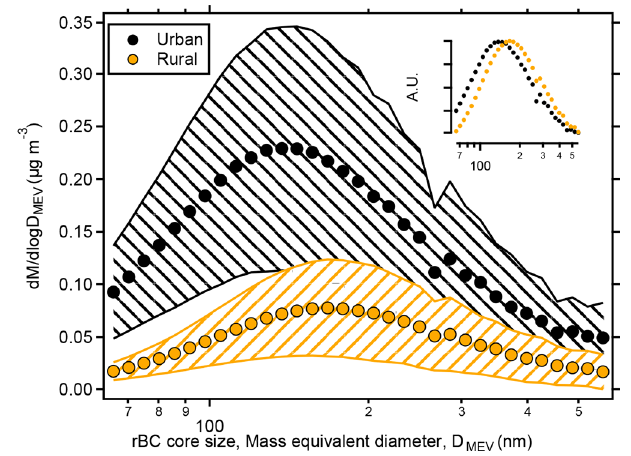
Figure 3. Average mass size distribution of BC cores for the urban (black) and rural (orange) campaigns. Filled areas show ± 1 σ . Insert shows the normalized distribution for comparison of the modes. Dip at 270nm is due to erroneous stitching of high and low gain detector